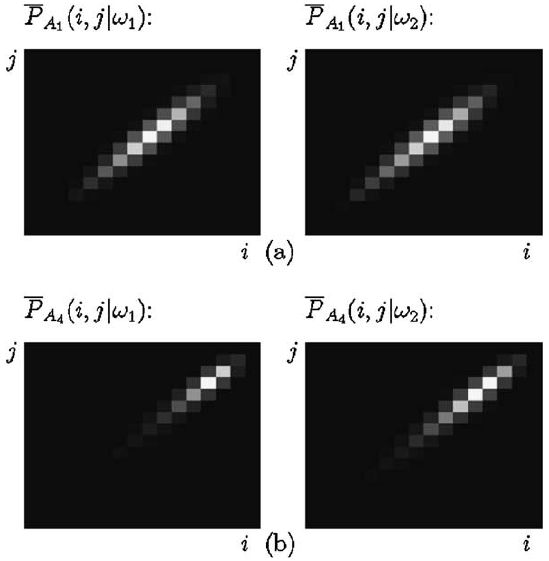
Fig. 4. The average Gray Level Cooccurrence Matrix (GLCM) P A ( i , j | ω c ) of the good prognosis ω 1 and the poor progno- a sis ω 2 classes of early ovarian cancer, computed from (a) all nu- clei within area interval A 1 (1000 (cid:1) area < 2000 pixels) and (b) all nuclei within area interval A 4 (4000 (cid:1) area < 5000 pixels). Lighter elements in the gray-scale plots correspond to higher prob- abilities. The matrices were computed from the 70% central part of the non-standardized nuclei.